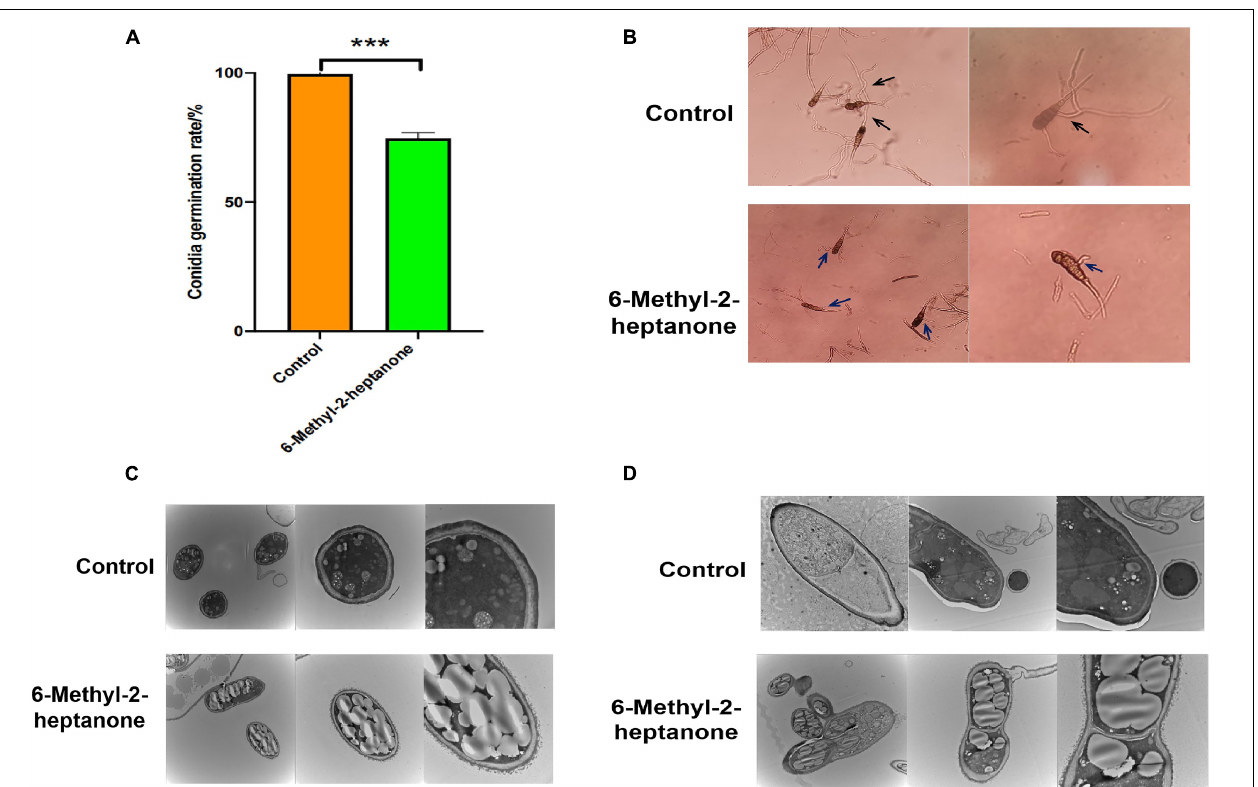
FIGURE 4 | Effects of 6-methyl-2-heptanone on conidia of A. solani . Here, 100 µ L of A. solani HWC-168 spore suspension (10 5 cfu/mL) was spread onto 1.0% water agar medium on a divided dish, and the other side of the dish was inoculated with an EC 50 value of 6-methyl-2-heptanone. (A, B) The conidial germination of A. solani in the control and 6-methyl-2-heptanone-treated groups, respectively. The “black arrow” represented conidia germinating normally with long germ tubes in the control sample; the “blue arrow” represented conidia with irregular germ tubes exposed to 6-methyl-2-heptanone. (C, D) Transmission electron micrographs of A. solani conidia in control samples and co-cultured with 6-methyl-2-heptanone samples. The results are presented as the means ± SDs ( n = 3). *** above points represent significant differences ( p <